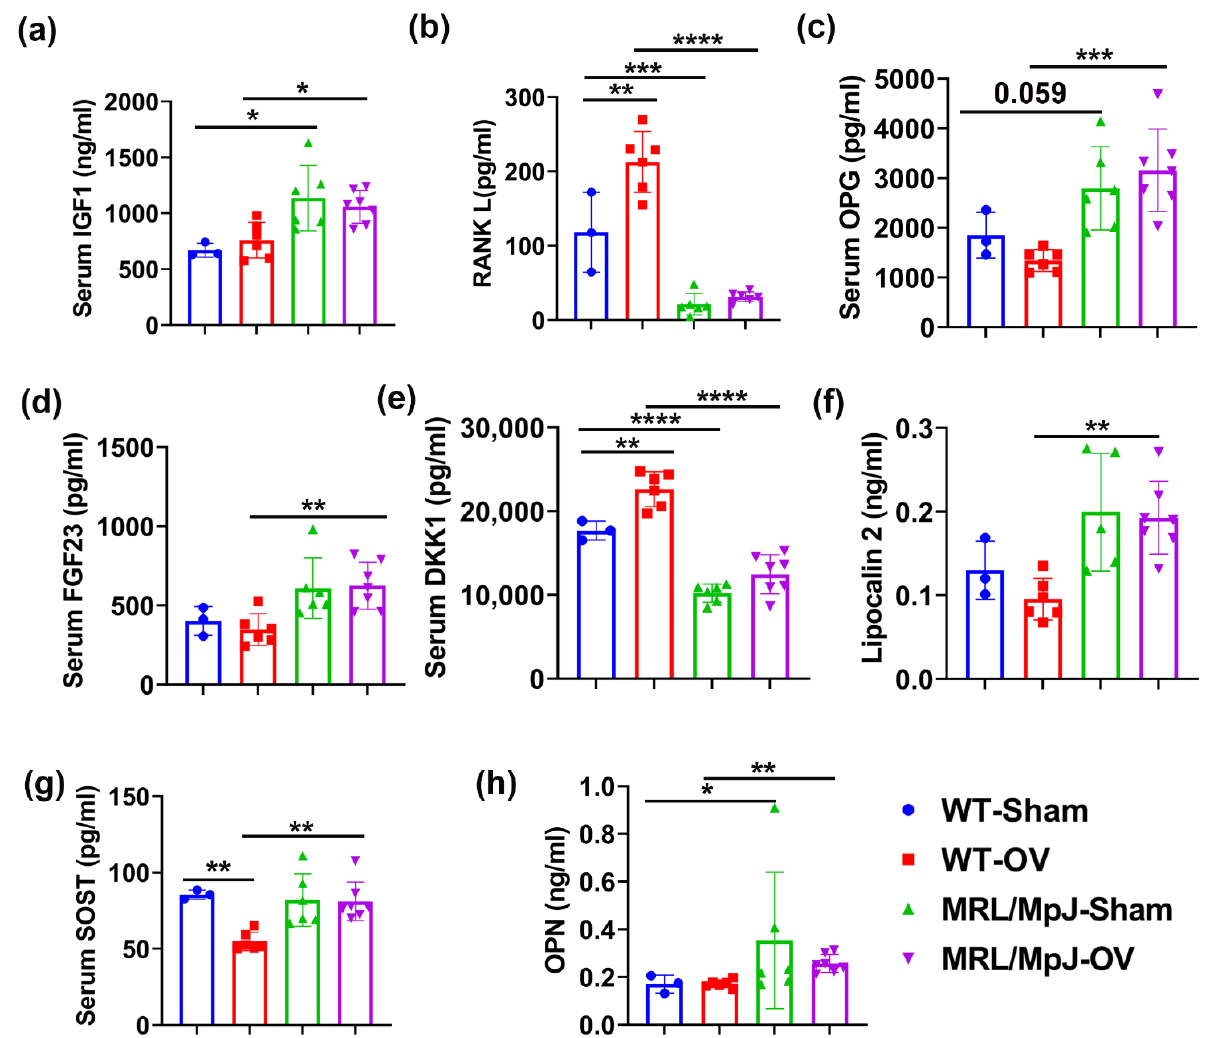
(Figure 9g). The serum OPN level in the MRL/MpJ-Sham mice was significantly higher than the level in the WT-Sham mice ( p = 0.05). The OPN level in the MRL/MpJ-OV mice was significantly higher than that of the WT-OV mice ( p < 0.01) (Figure 9h). No statistical differences were found between groups for other factors measured.